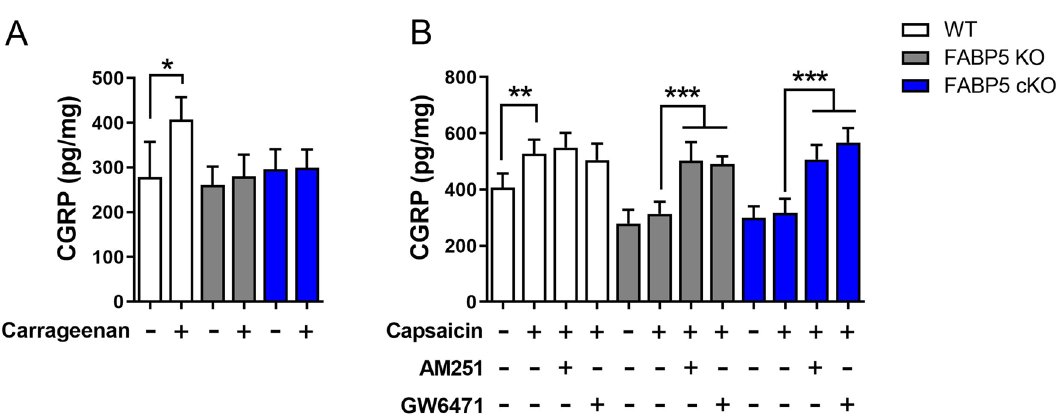
Figure 3. CB1 and PPARα mediate the antinociceptive effects in FABP5 cKO mice. ( A ) Levels of AEA, PEA, OEA, and 2-AG in DRGs of male and female FABP5 Flox and FABP5 cKO mice at baseline and 4 h after intraplantar carrageenan injection. ** p < 0.01; *** p < 0.001 vs WT and FABP5 Flox calculated using two-way ANOVA followed by Bonferroni post-hoc test (n = 5). ( B ) Percent expression of CB1, PPARα, FAAH, NAPE- PLD, and ABHD4 in DRGs of male and female FABP5 cKO mice relative to FABP5 Flox controls. ( C ) FAAH and NAPE-PLD activity in DRGs. Left: DRGs were incubated with the selective FAAH substrate AMC-AEA (100 µM). Right: DRGs were incubated with the phospholipase A1 substrate PED-A1 (10 µM) in the presence or absence of the selective NAPE-PLD inhibitor LEI-401 (30 µM) (n = 3). ( D ) Thermal withdrawal latencies in FABP5 cKO mice receiving vehicle, AM251 (3 mg/kg, i.p.), or GW6471 (4 mg/kg, i.p.). *** p < 0.001 calculated using one-way ANOVA followed by Dunnett’s post-hoc test (n = 6).